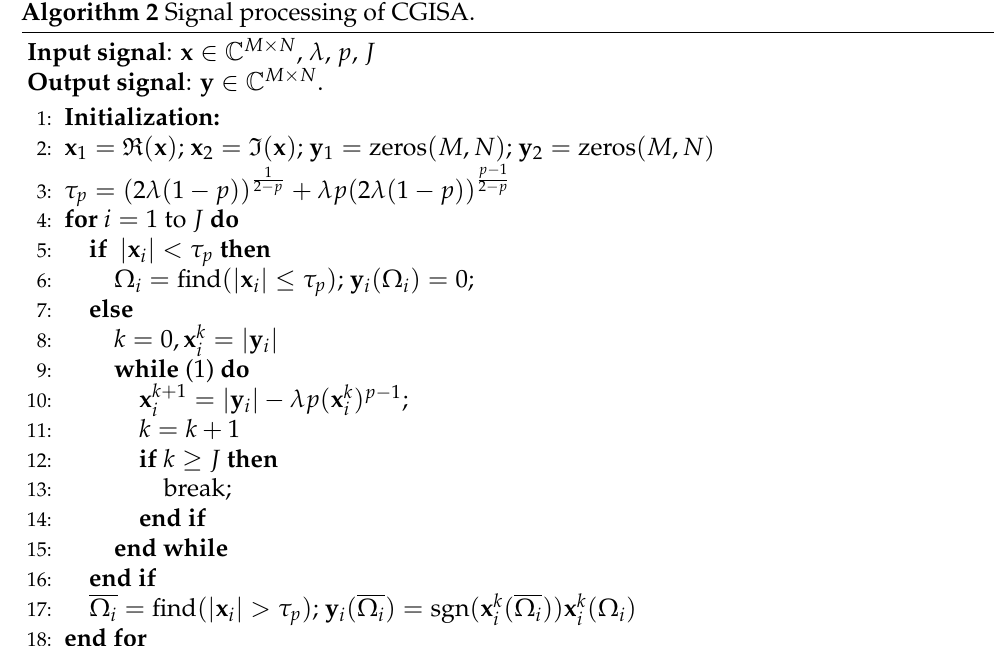
Algorithm 2 Signal processing of